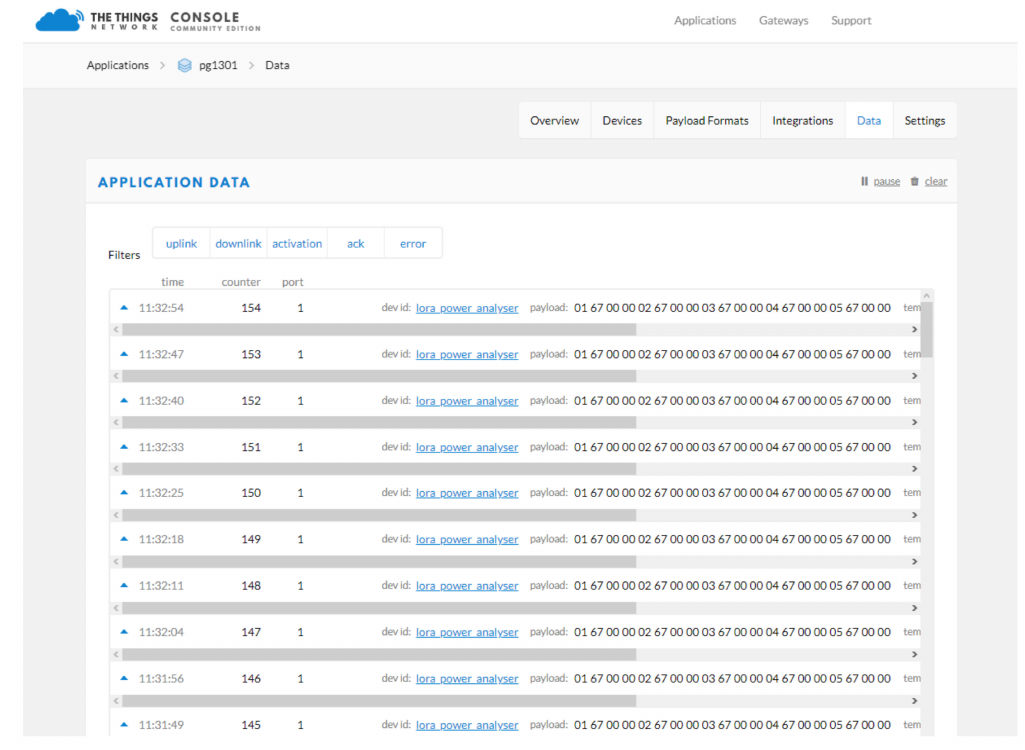
Figure 25. Data uploaded to The Things Network (TTN).